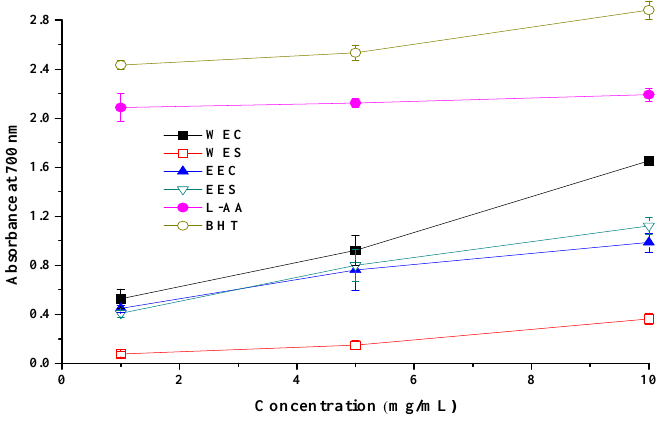
Concentration ( mg/mL ) Each value is expressed as mean ± S.D. (n =